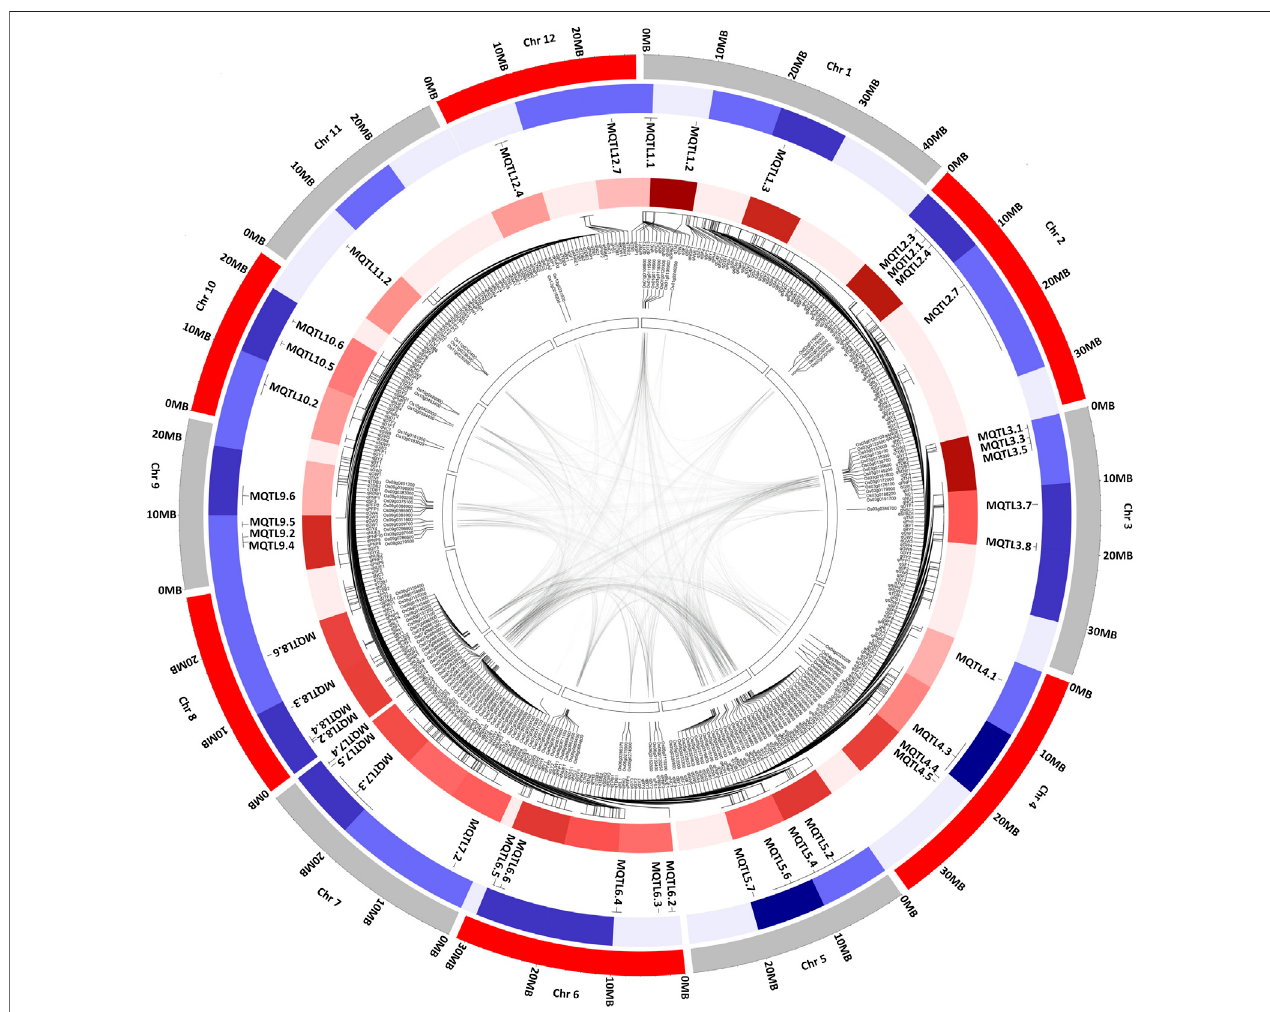
FIGURE 3 | Schematic representation of the distribution pattern of identi fi ed MQTL, QTL, and candidate genes on rice chromosomes. From the center of the plot moving to the outer circle (1) The innermost circle representing the collinearity within the rice genome (2) Candidate genes identi fi ed in the major MQTL region (3)(query) QTL density in the MQTL region (4) MQTLs associated with nitrogen use ef fi ciency and related traits (5) Outermost circle represents the rice genome in MB. The color density indicates the number of MQTL detected and number of QTLs present in the MQTL region. The denser color indicates a greater number of MQTL or QTL within the MQTL